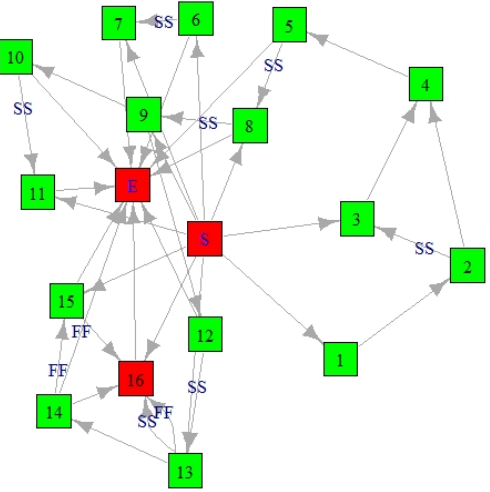
Figure 4. AON graph of the project. In an AON graph the activities are embodied in the nodes (squares) and the precedences of the various types, FS, SS, FF, SF, in the arcs (arrows). Nodes in red indicate critical activities.